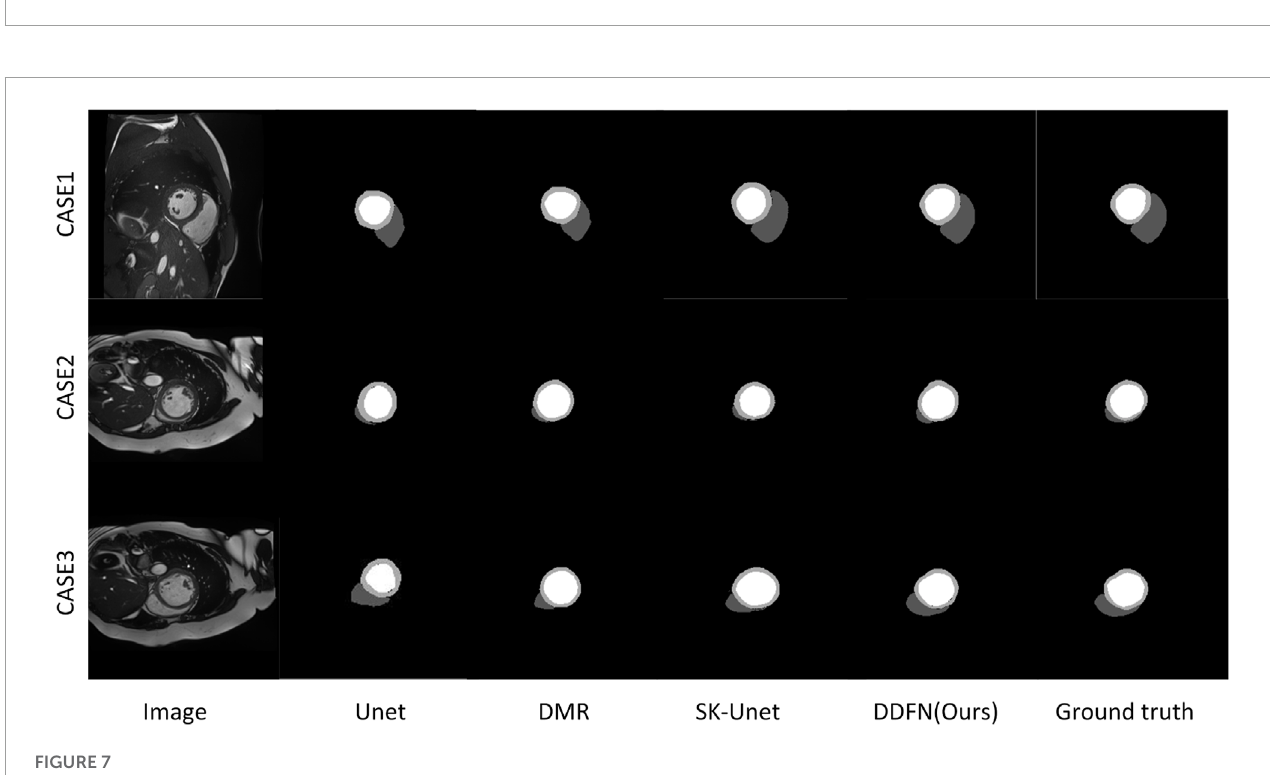
FIGURE 7 The variation of